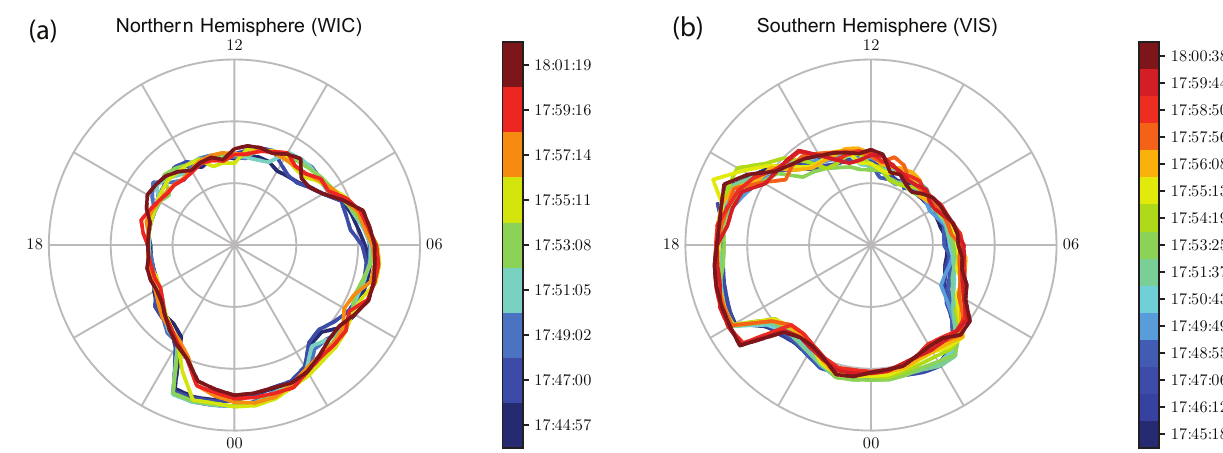
Figure 12. Open–closed boundaries derived from IMAGE WIC images in the north and Polar VIS in the south from 17:45 to 18:01UT on 17 August 2001.